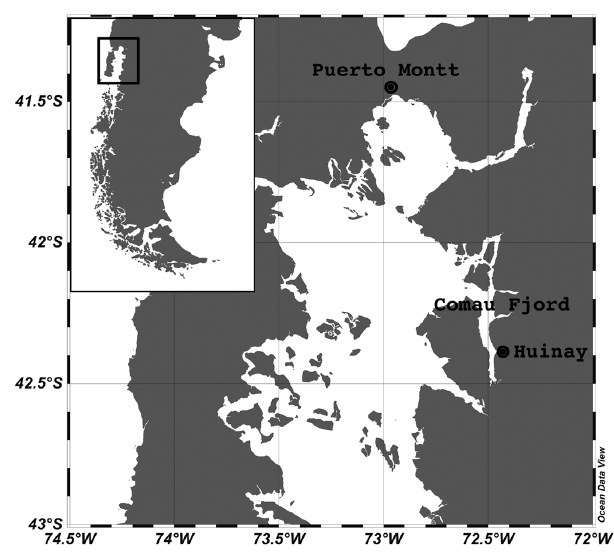
Fig. 1. Comau Fjord and Huinay Field Station in the Los Lagos region,